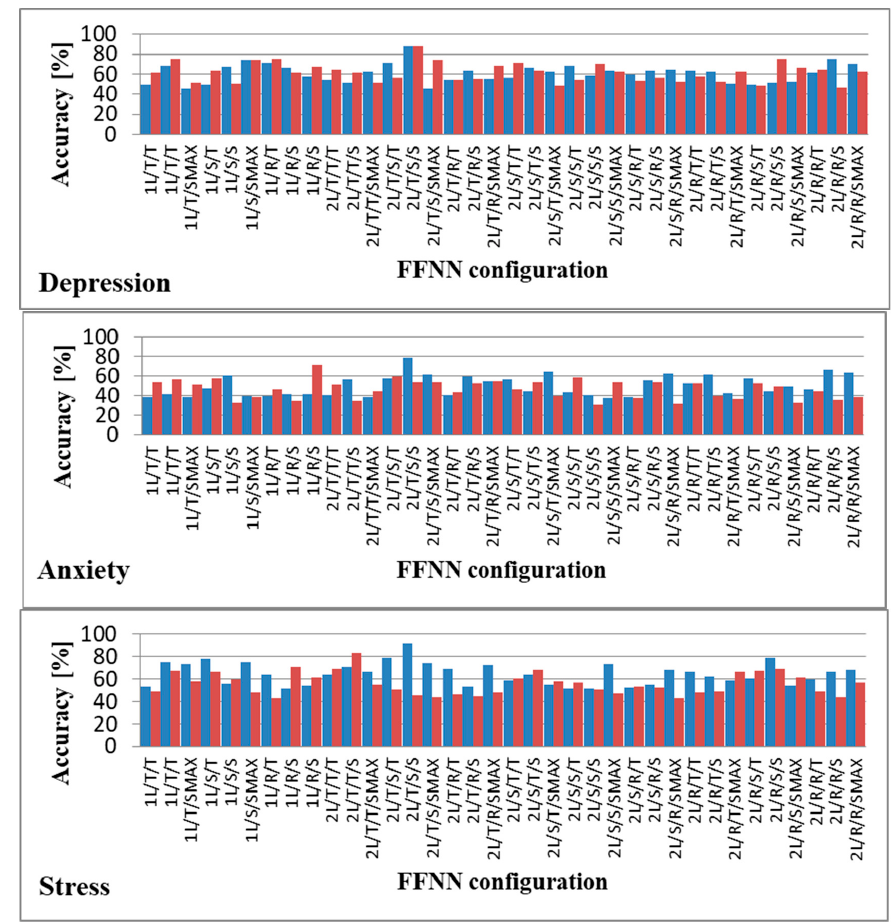
Figure 5. Prediction accuracy using different combinations of neural networks. T: tanh; S: sigmoid;